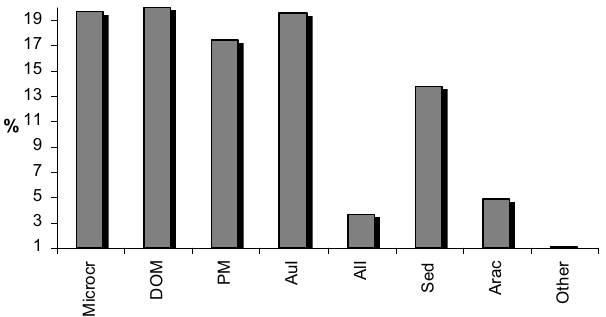
Fig. 1. Percent composition of Eigenmannia trilineata ali- mentary items calculated for both adult and